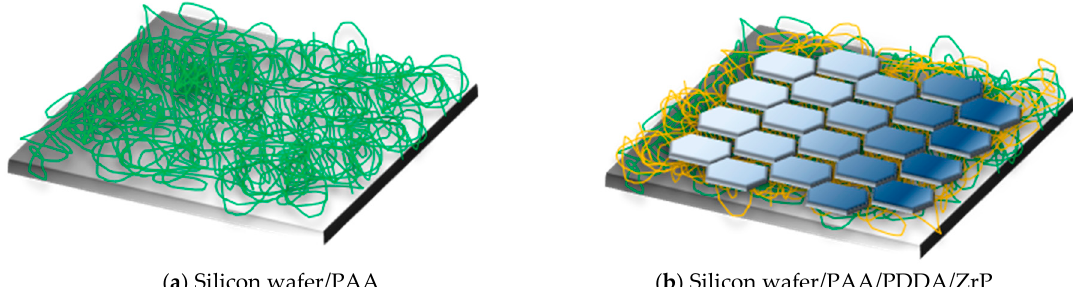
Figure 11. Schematics of ( a ) silicon wafer coated with PAA and ( b ) with PAA/PDDA/ZrP.